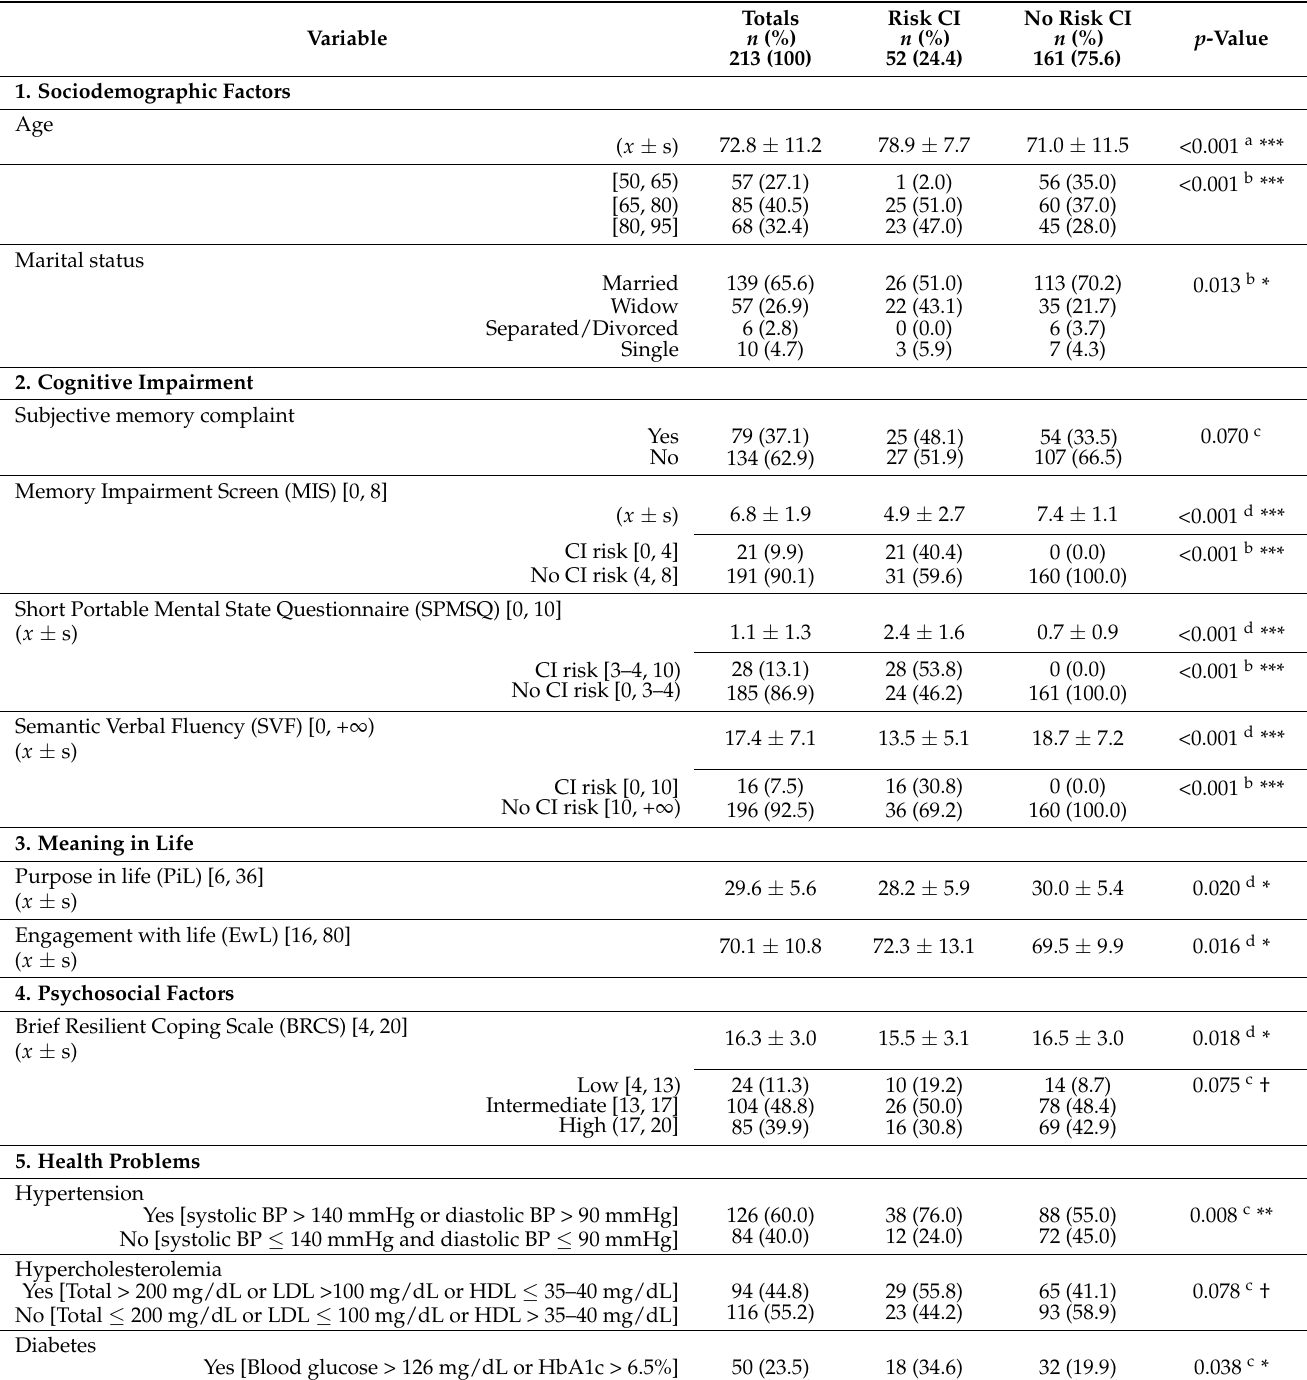
Table 4. Variables associated with cognitive